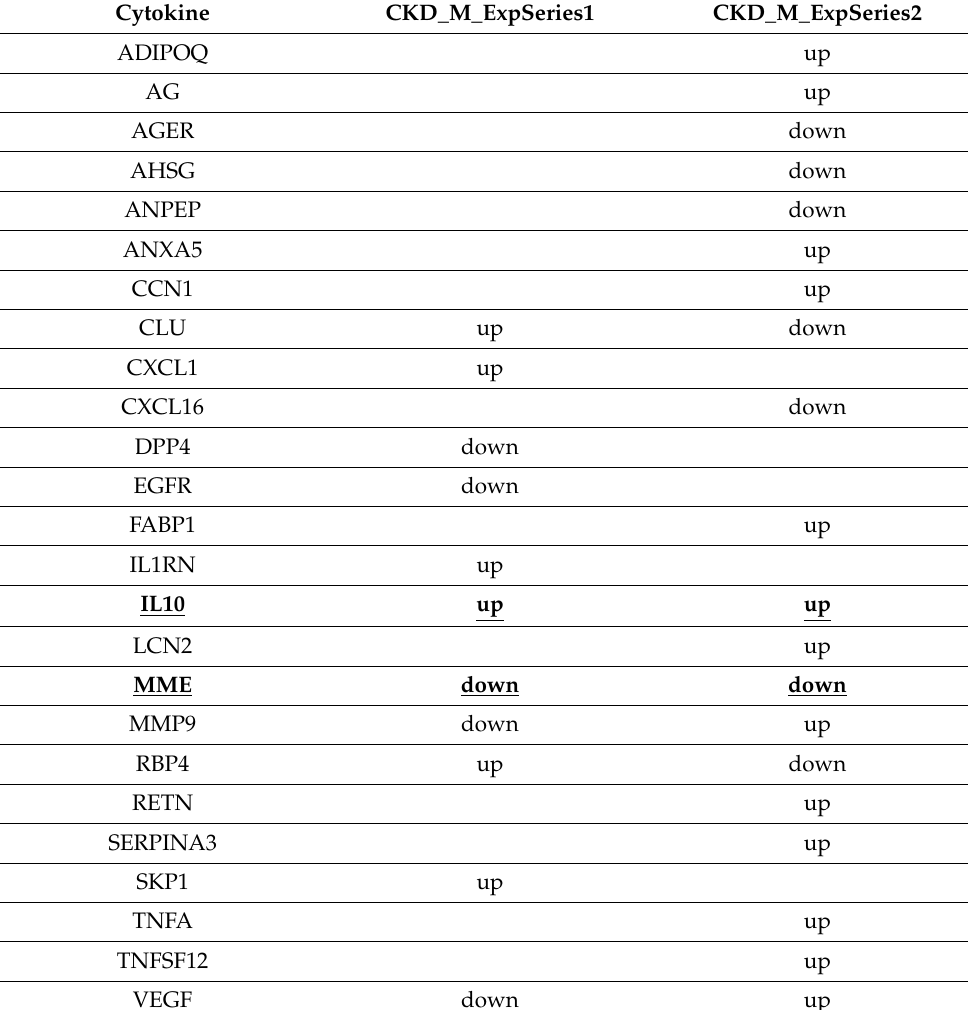
Table 2. CKD markers identified in male CKD patients in experiment series 1 and